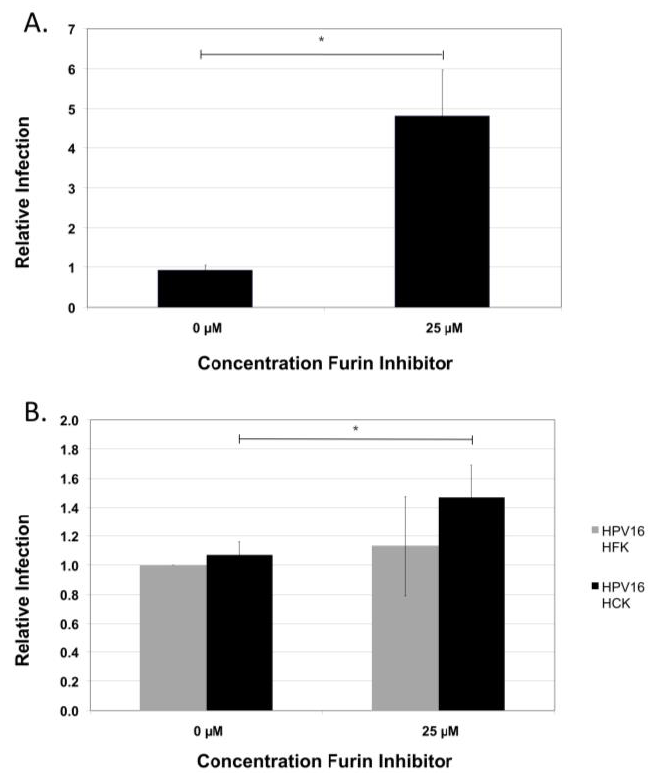
Figure 6. Furin-independent infection with cervical cell-derived HPV16. ( A ) Infection of HaCat cells with cervical cell-derived HPV16 in the presence or absence of 25 µM furin inhibitor; ( B ) Infection of primary keratinocytes with foreskin and cervical cell-derived HPV16 in the presence or absence of 25 µM furin inhibitor. Infections were analyzed by RT-qPCR measuring the relative amount of E1^E4 transcript two days post-infection normalizing to infections done in the absence of furin inhibitor. The results are expressed as the means of at least three independent infections utilizing at least two different virus preps and standard deviations are shown. Statistical significance (denoted by asterisks) was determined by student’s t -test and significance was defined as p ď